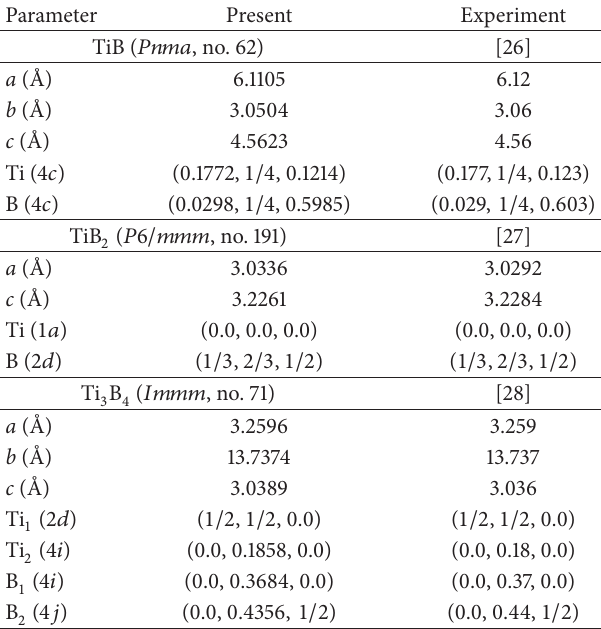
Table 1: Structural parameters of TiB, TiB 2 , and Ti 3 B 4 determined at the ground state and from experiments [26–28].